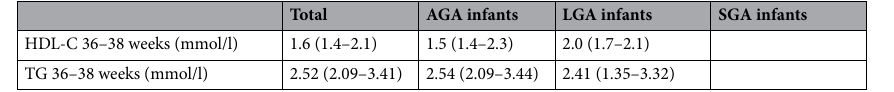
Table 1. Characteristics of the study population. AGA appropriate-for-gestational age, LGA large-for- gestational age, SGA small-for-gestational age, C cholesterol, TG triglycerides. a WHO2013, with representative OGTT. Data given as mean ± SD when normal distributed and median (25th, 75th) when skewed distributed. *p < 0.05, **p < 0.01, ***p < 0.001.